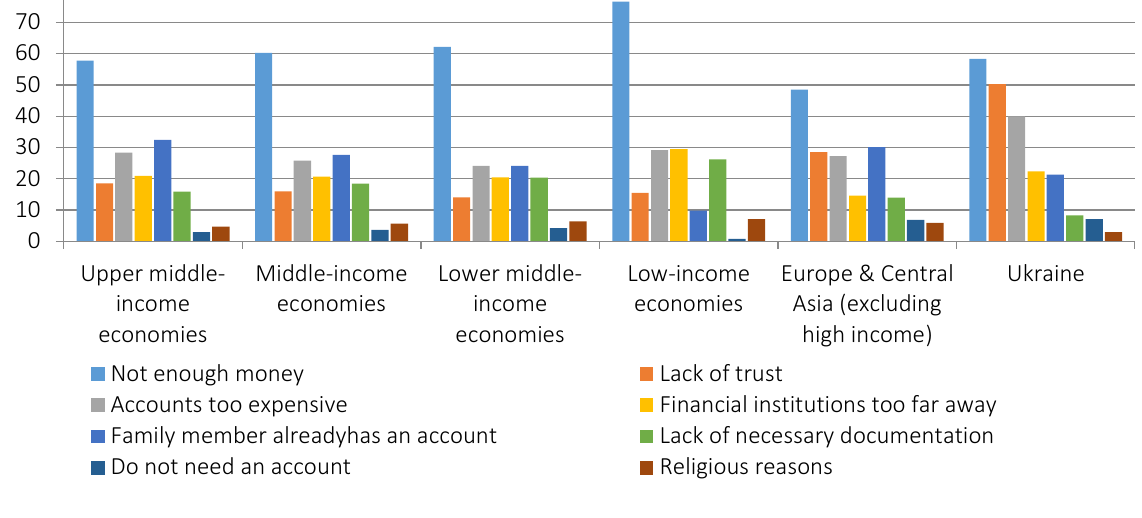
Figure 4. Financially excluded adults due to barriers